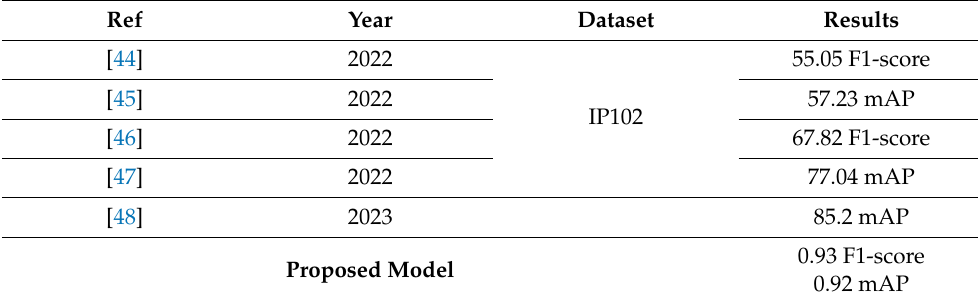
Table 5. Localization results in comparison.